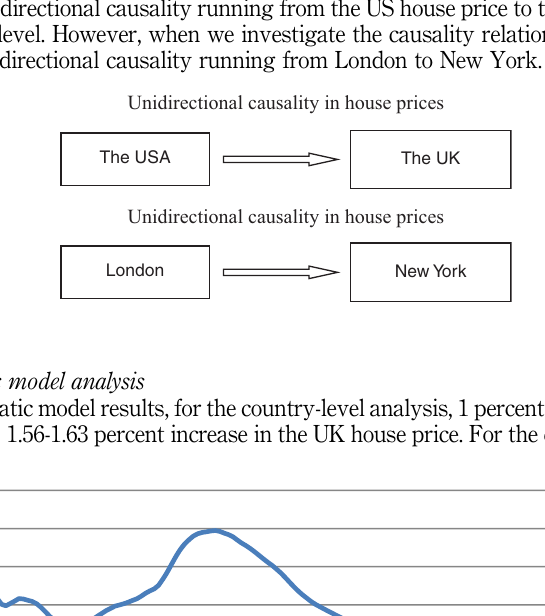
Figure 3. Time-varying